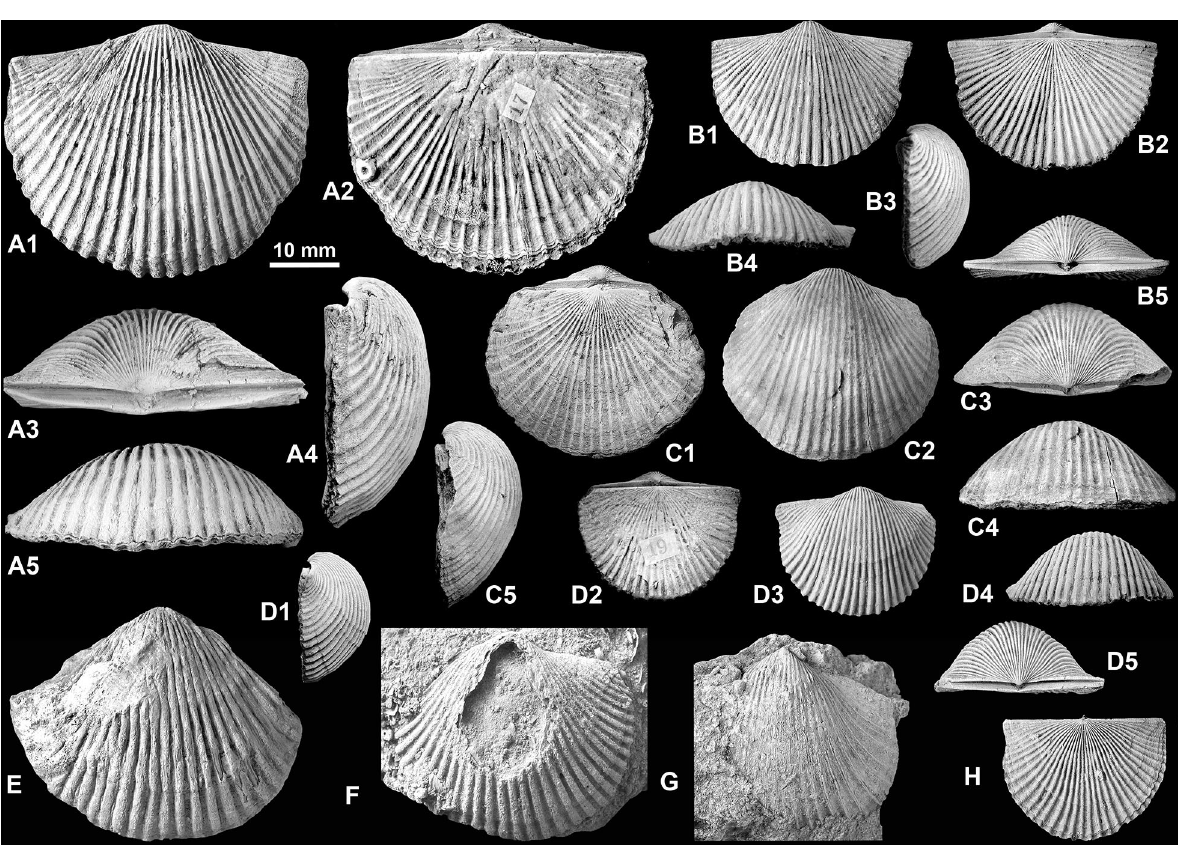
Fig. 1. A1 – A5 , Cyrtonotella kuckersiana kuckersiana (Wysogórski, 1900), neotype, shell TUG 1054-17 (Br 077), ventral, dorsal, posterior, lateral and anterior views, Ubja, northeastern Estonia, Kukruse Regional Stage (RS). B1 – B5 , Cyrtonotella kuckersiana frechi (Wysogórski, 1900), neotype, shell GIT 400-70, ventral, dorsal, lateral, anterior and posterior views, Pääsküla (western part of Tallinn), Jõhvi Substage of the Haljala RS. C1 – C5 , Cyrtonotella barbara (Öpik, 1930a), holotype, shell TUG 1054-24 (Br 084), dorsal, ventral, posterior, anterior and lateral views, Sõjamägi (Tallinn), Haljala RS. D1 – D5 , Cyrtonotella laine (Öpik 1930a), holotype, shell TUG 1054-19 (Br 084), lateral, dorsal, ventral, anterior and posterior views, Kohtla, northeastern Estonia, Kukruse RS. E , Cyrtonotella kuckersiana kuckersiana (Wysogórski, 1900), ventral valve ELM G1:7957, Jõhvi, northeastern Estonia, Jõhvi Substage of the Haljala RS. F , Cyrtonotella kuckersiana kuckersiana (Wysogórski, 1900), ventral valve ELM G1:7724, Kavastu, northeastern Estonia, Jõhvi Substage of the Haljala RS. G , Cyrtonotella kuckersiana cf. kuckersiana (Wysogórski, 1900), ventral valve ELM G1:4948, Tallinn, Uppermost Darriwilian (Uhaku RS). H , Cyrtonotella kuckersiana kuckersiana (Wysogórski, 1900), exterior of dorsal valve GIT 400-124, Kukruse, northeastern Estonia, Kukruse RS. The scale is the same for all